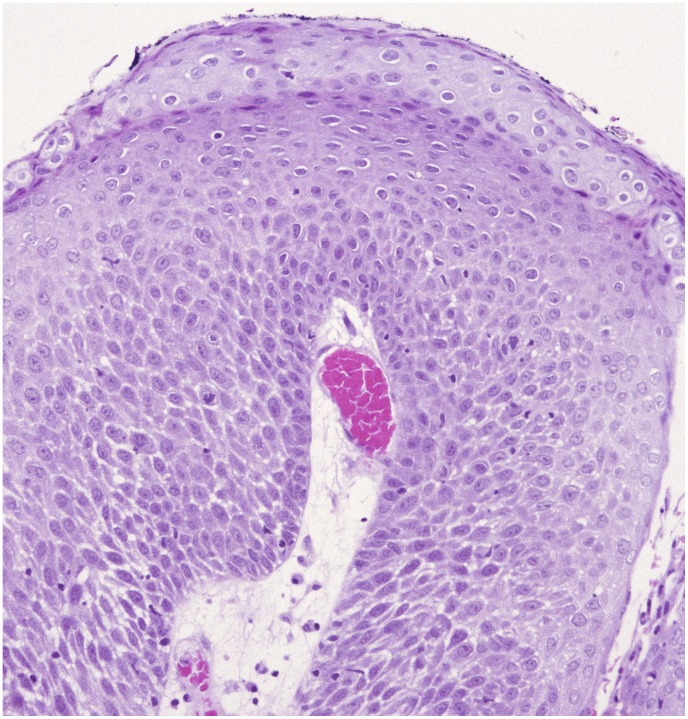
Laryngeal papilloma with moderate dysplasia (SIN 2) in a patient with adult-onset RRP (HEx20).